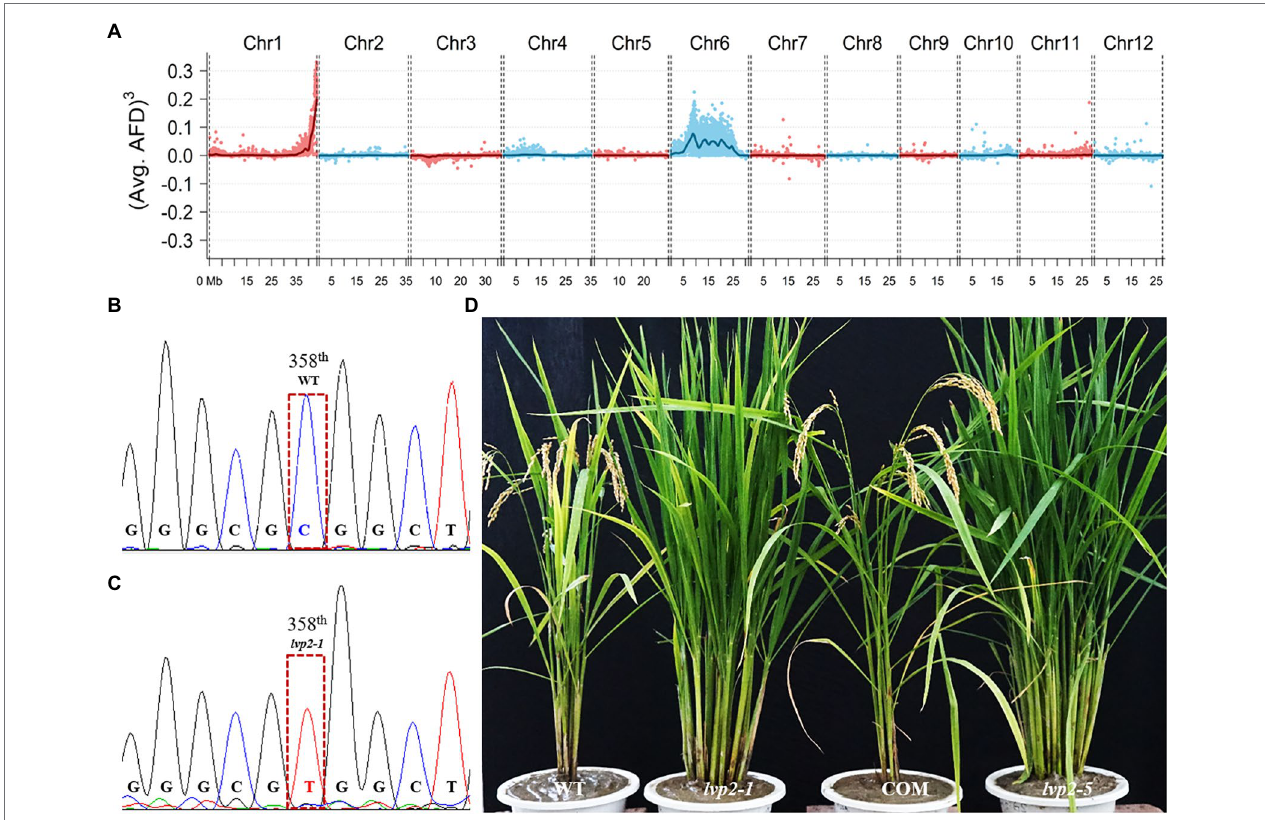
FIGURE 2 | Identification and characterization of OsLUX function. (A) Mapping and screening the candidate gene of LVP2 by resequencing the DNA pools of WT and mutant. LVP2 was located on the terminal region of the long arm of chromosome1. (B,C) A single base transversion (C to T) was found in lvp2-1 , which resulted in the change of the 120th aa from Arginine to Tryptophan. (D) Functional validation of OsLUX via genetic complementation and gene editing. The WT phenotype was recovered by genetic complementation in the transgenic lvp2-1 plant, whereas the loss-of-function mutant plant showed lvp2-1 phenotype. COM, a genetic complementation plant; lvp2-5 , a non-functional allele generated by CRISPR/Cas9 editing, which encoded a truncated peptide of OsLUX consisting of only 18 amino